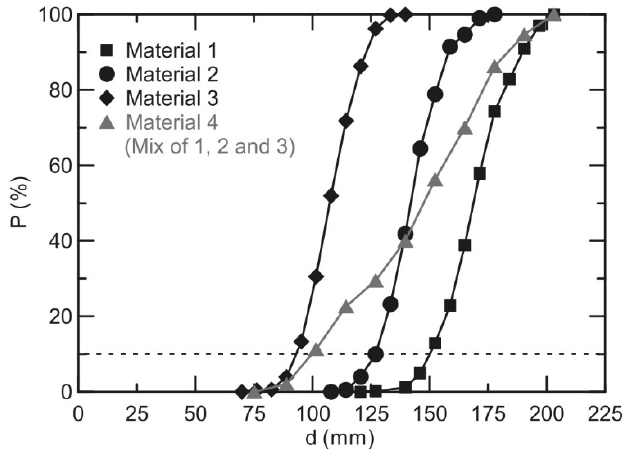
Figure 9. Equivalent sphere-size distribution of tested material. d, particle diameter, mm; P, percentage passing, % (Fillion et al., 2011 [7]).